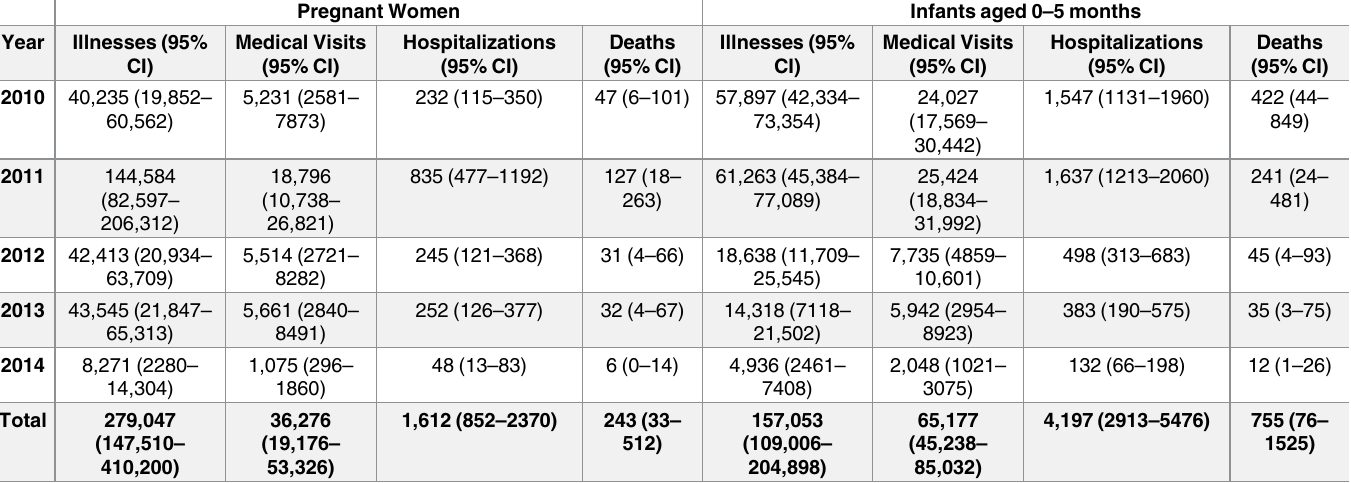
Table 2. Baseline estimatesof influenza illnesses, medical visits, hospitalizations and deaths among pregnant women and infants aged 0–5 months in Kenya, 2010–2014.